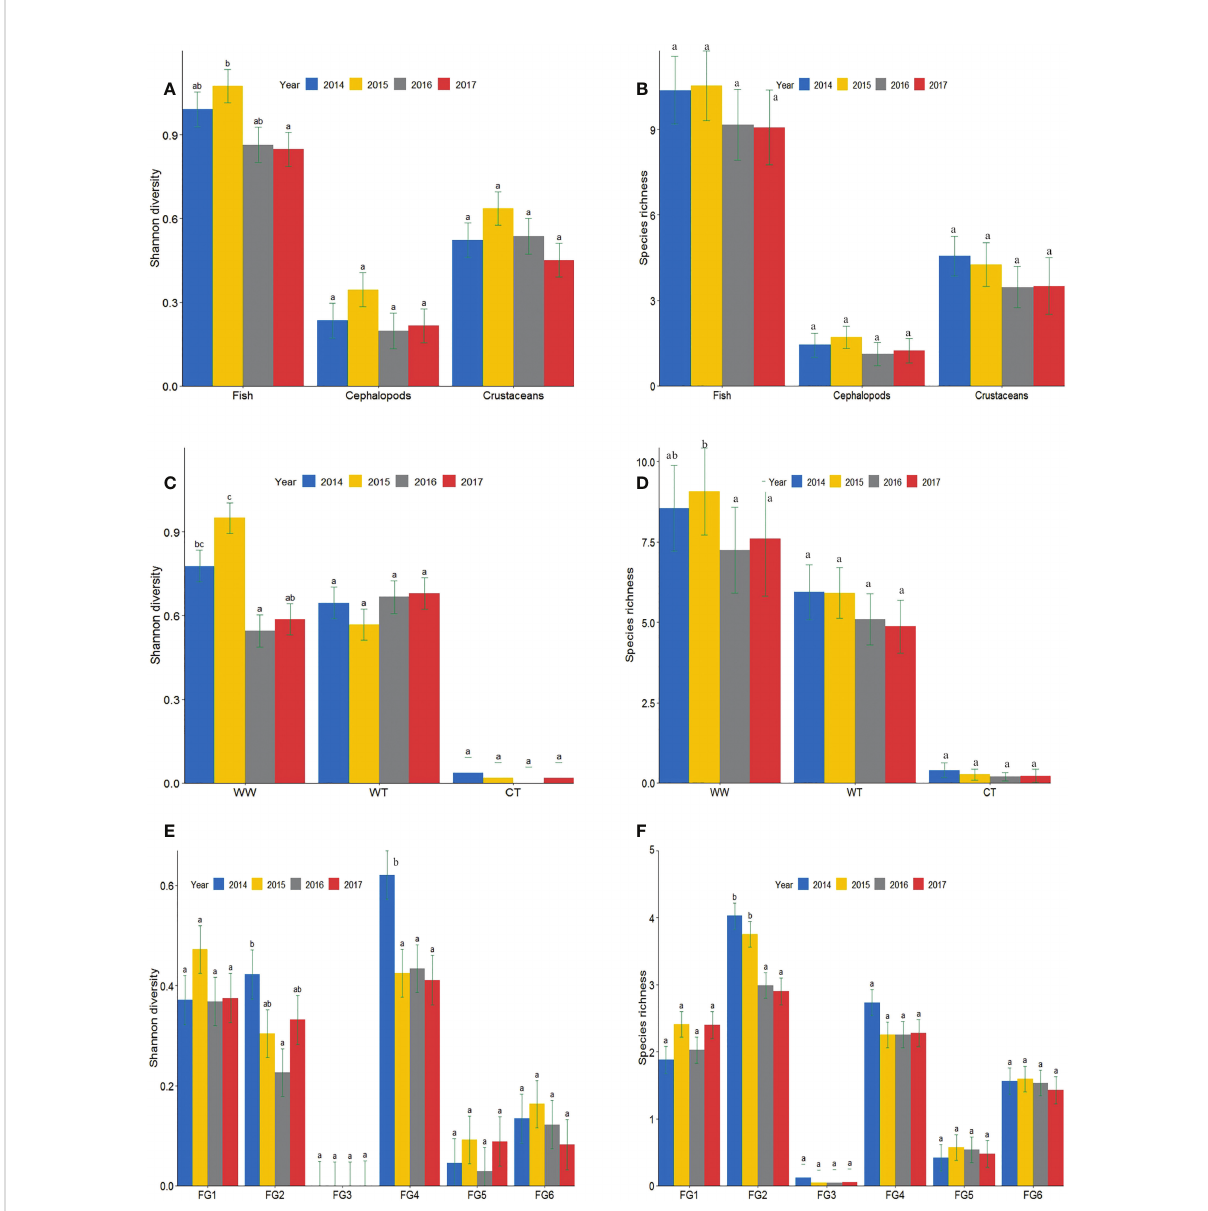
FIGURE 9 Group comparisons of (a-b) taxa, (c-d) thermal preference, and (e-f) feeding functions in terms of the Shannon diversity and Chao1 richness indices between the years before (2014 – 2015) and during (2016 – 2017) the MHW events. The bar column represents the mean ± standard error of richness and diversity among the different study groups. Letters indicate signi fi cance using Tukey ’ s post-hoc multi-comparison test for one- way ANOVA of mean richness and diversity